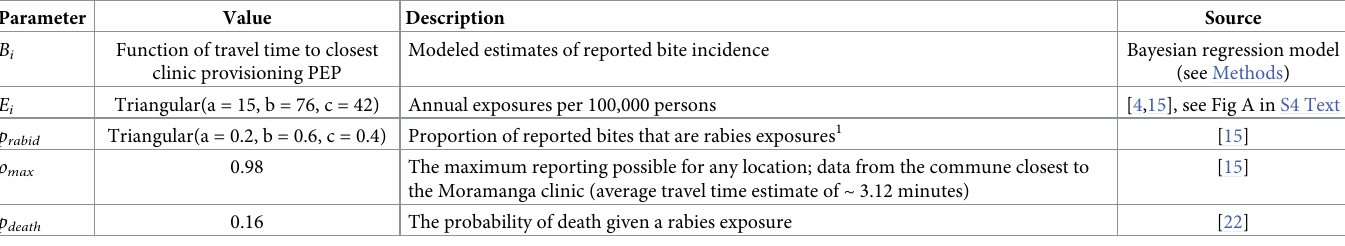
Table 1. Parameters used in the decision tree to estimate human rabies deaths at the administrative